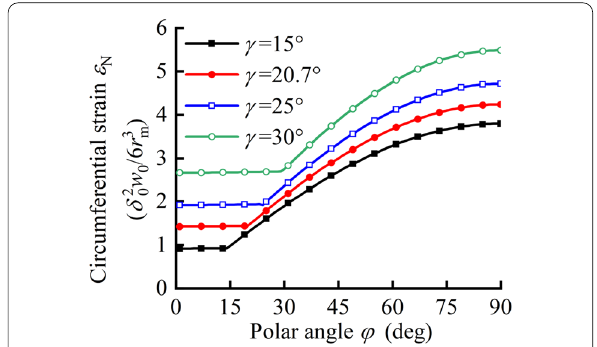
Figure 22 Circumferential strain of ring under eccentric disks